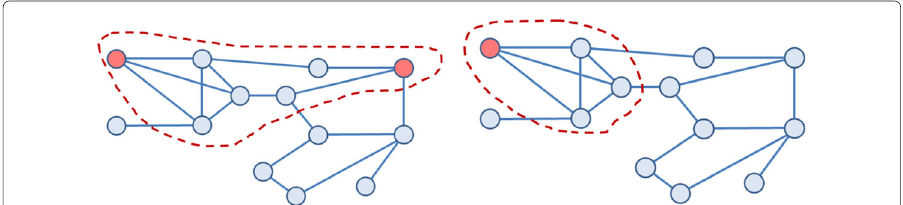
Fig. 2 Demonstration of underlying communities (circled) towards which to calculate node relevance given example nodes (highlighted). Removing one of the two example nodes heavily impacts the community we would want a ranking algorithm help